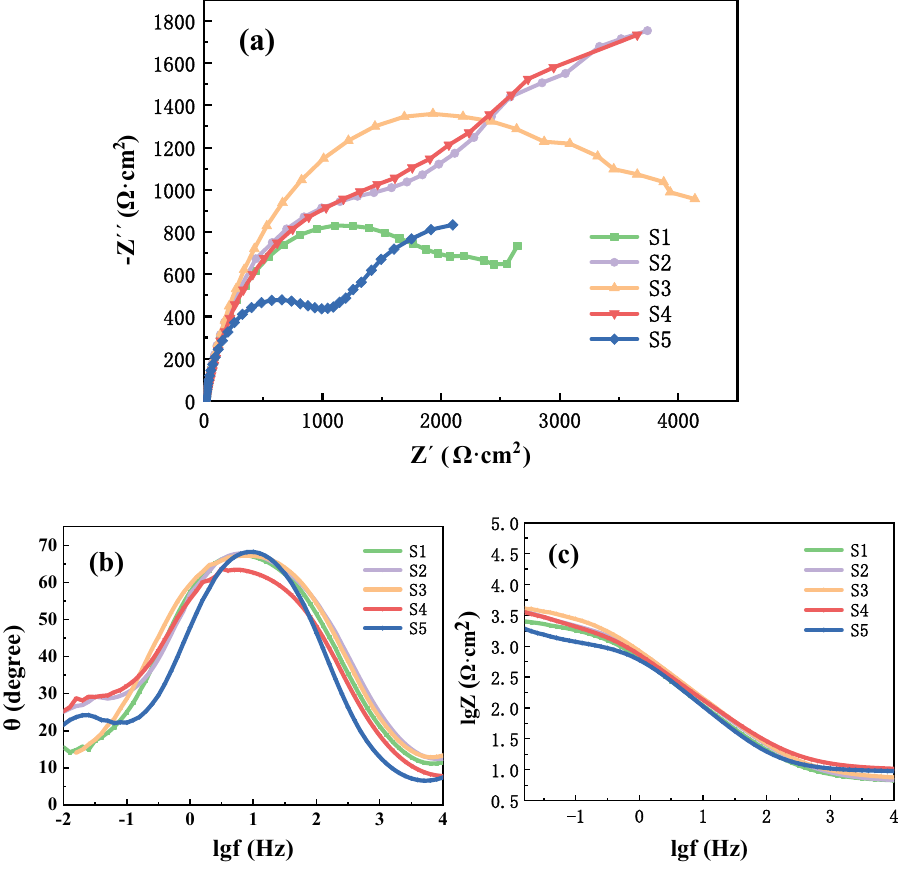
Figure 10: EIS of the coatings with di ff erent Y 2 O 3 addition in 3.5 wt% NaCl solution: ( a ) Nyquist plot, ( b ) Bode plot ( phase angle – frequency plot ) , and ( c ) Bode plot ( module – frequency plot )